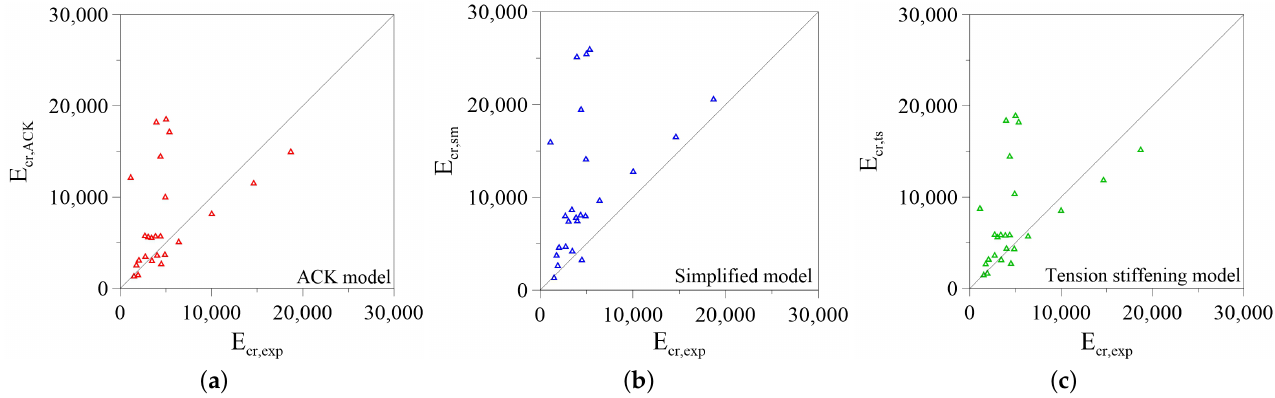
Figure 10. Comparison between analytical and experimental fracture energy: ( a ) Aveston–Cooper–Kelly (ACK) Model; ( b ) Simplified Model; ( c ) Tension Stiffening Model.